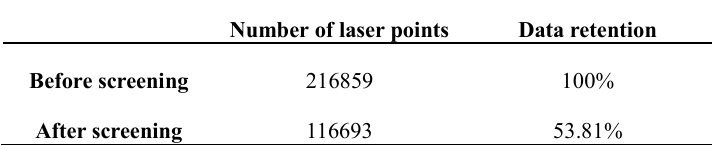
Table 1. Fine filtering results based on waveform data